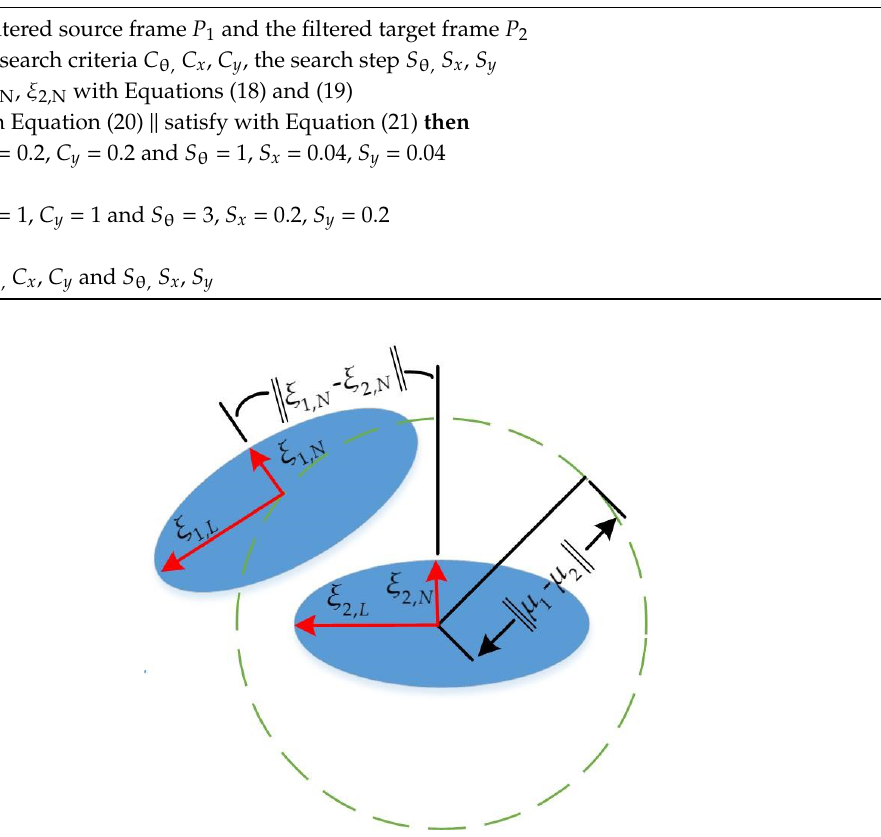
Algorithm 2: Adaptive Threshold Selection